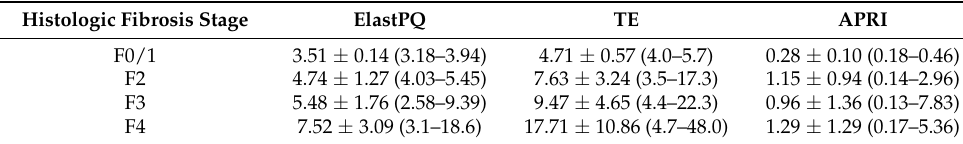
Table 2. Values of ElastPQ, TE, and APRI according to the fibrosis stage.